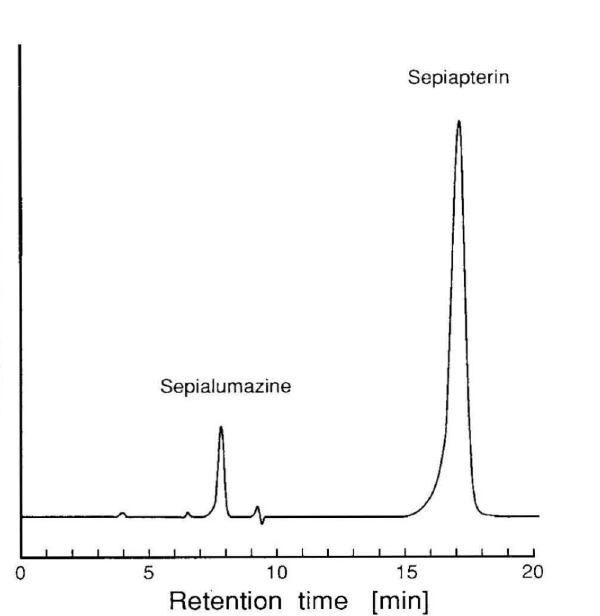
Figure 1. A typical H PLC elution profile of reaction mixture. Conditions were as follows: Column system: Asahipac GS-320H (7.6 x 250 mm), 10% acetonitrile containing 10 mM potassium phosphate buffer (PPB) pH 7.0. Flow rate, 1.0 ml/min, detected by absorbance at 420